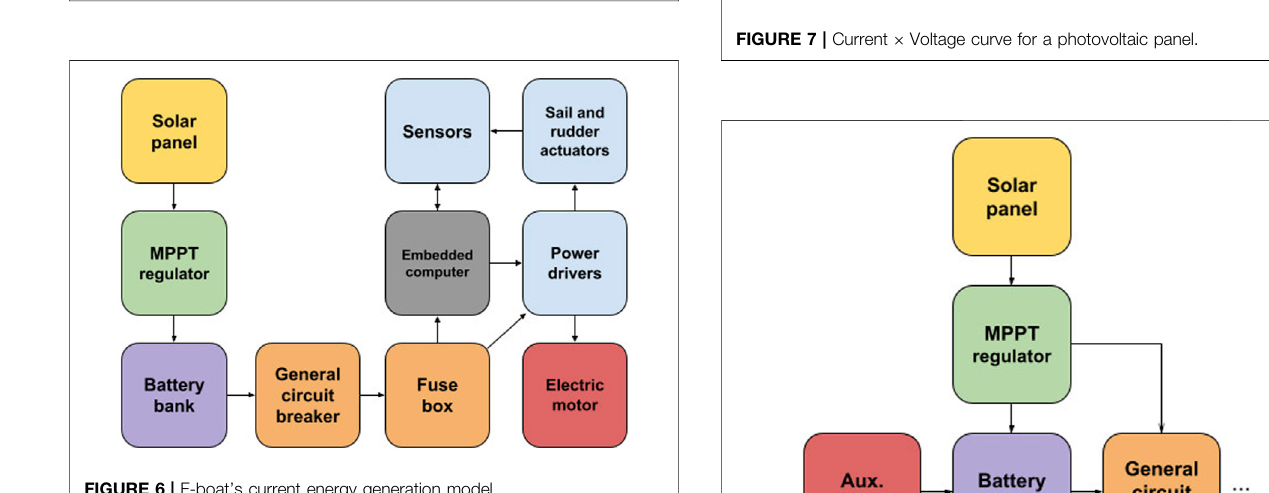
FIGURE 6 | F-boat ’ s current energy generation model.